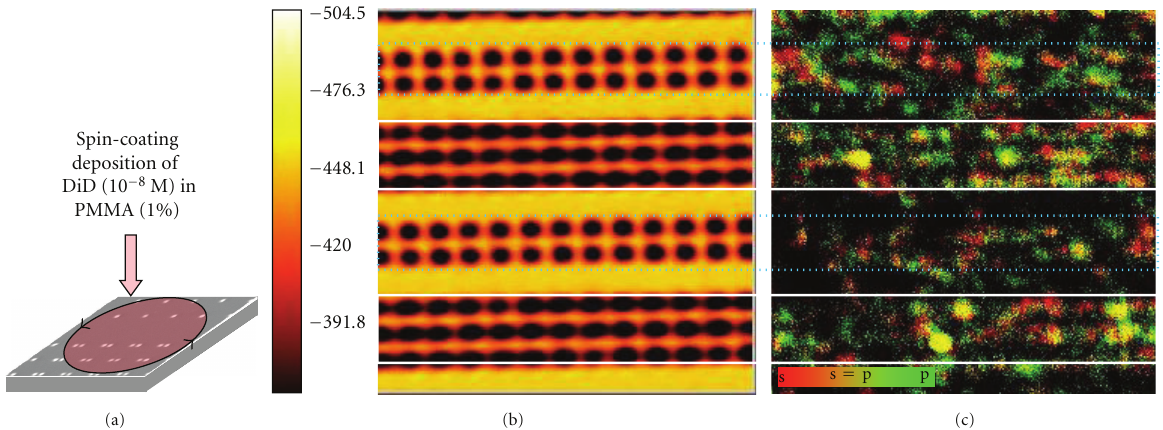
Figure 8: (a) Scheme of a random deposition of molecules over samples as described in Figure 4(a). (b) Optical transmission microscopy image and (c) fluorescence microscopy image. The white and blue squares highlight the dimer and monomer regions, respectively. The color scale in (c) indicates the polarization as given in Figure